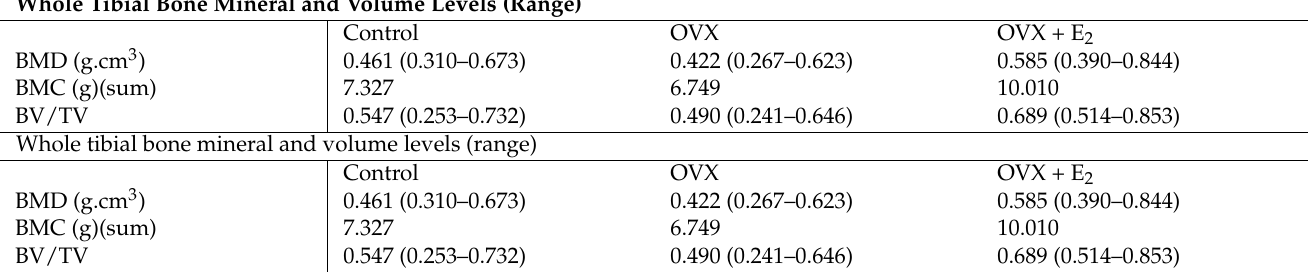
Table 6. A comparison of the mean values obtained for whole bone mineral and volume levels in the control, OVX, and OVX + E 2 experimental groups following the 12-week study period. Whole Tibial Bone Mineral and Volume Levels